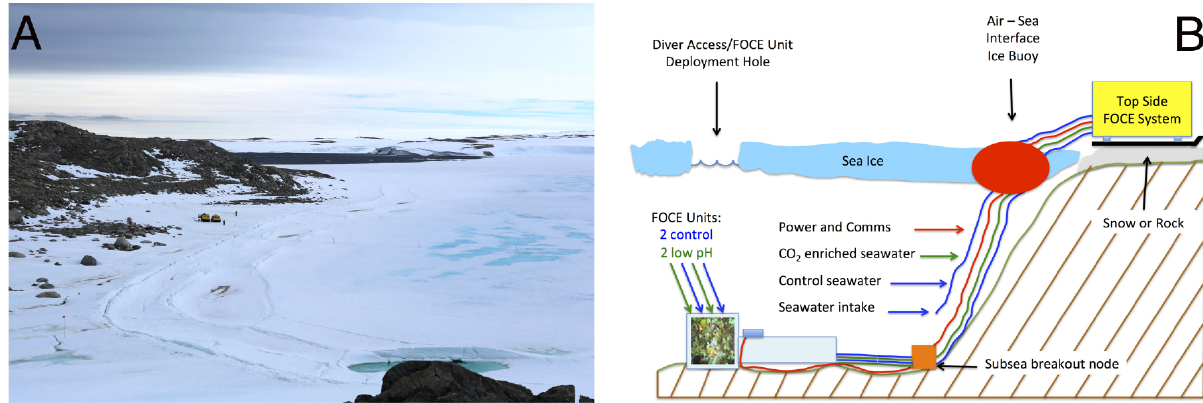
Figure 5. (A) antFOCE site (O’Brien Bay, Antarctica); (B) simplified sketch of the antFOCE system. Credits: (A) G. Johnstone (AAD) and (B) W. Kirkwood (MBARI) and J. Reeve